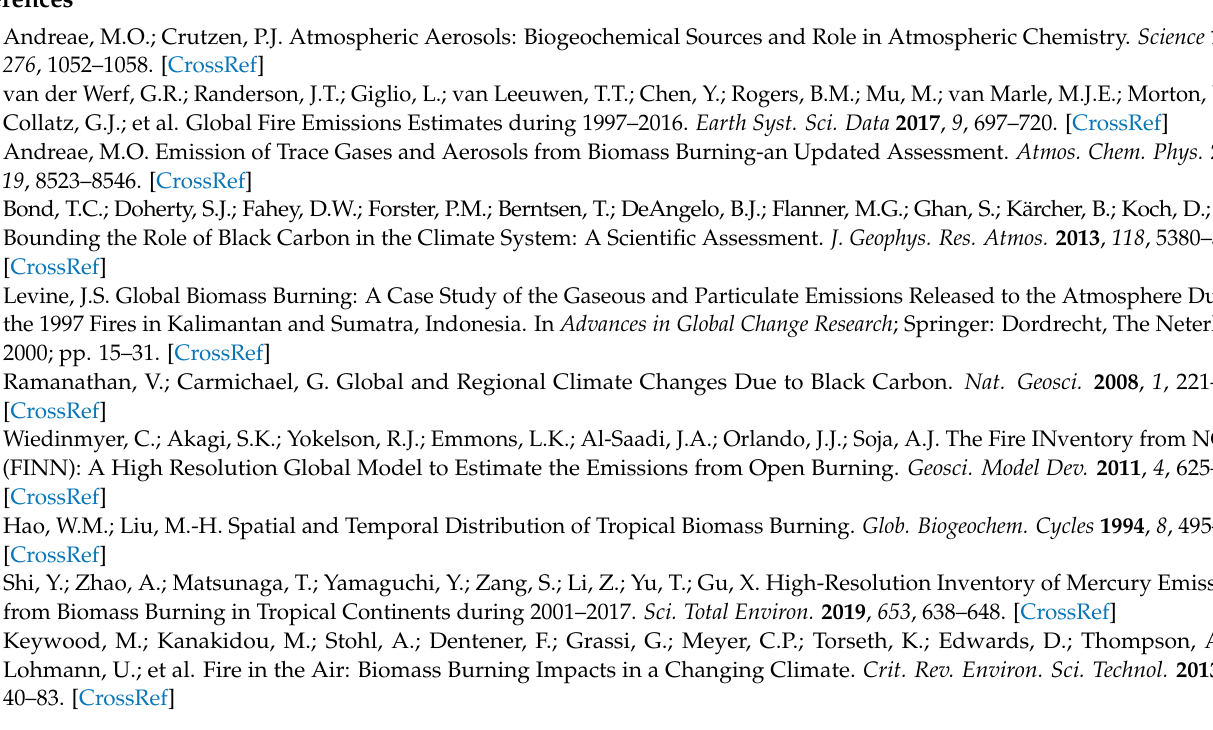
Figure S2: Monthly average (2001–2020) of combustion efficiency (CE); Table S1: Inter-annual vari- ations (2001–2020) of emissions in Tg over western Himalaya; Table S2: Inter-annual variations (2001–2020) of emissions in Tg over Nepal/Central Himalaya; Table S3: Inter-annual variations (2001–2020) of emissions in Tg over eastern Himalaya; Figure S3: Inter-annual variations of forest fire emissions from 2001-2020 over the entire study area; Figure S4: Average monthly (2001–2020) forest fire emissions over the study area; Figure S5: Annual forest fire emissions from Global Fire Emission Dataset 4.1 (GFED4.1) over Himalaya. Figure S6: Population density of 2015 (persons/km2) over the study area. Figure S7: Wind vector plot on 950 hPa pressure level of March, April and